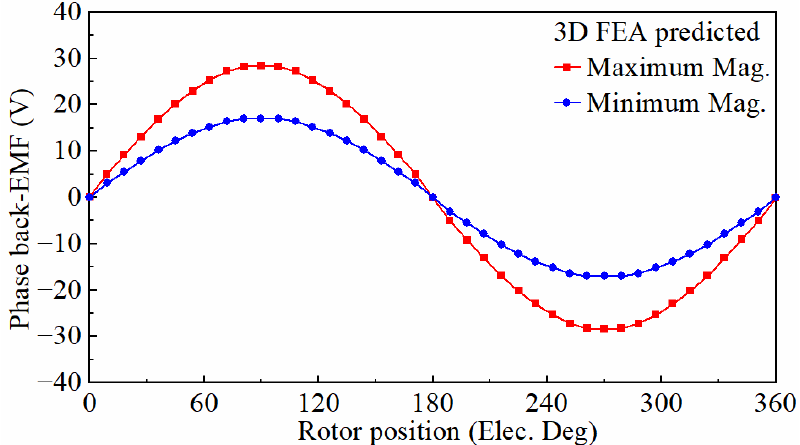
Figure 11. Open circuit phase back-EMFs under maximum and minimum magnetization states.